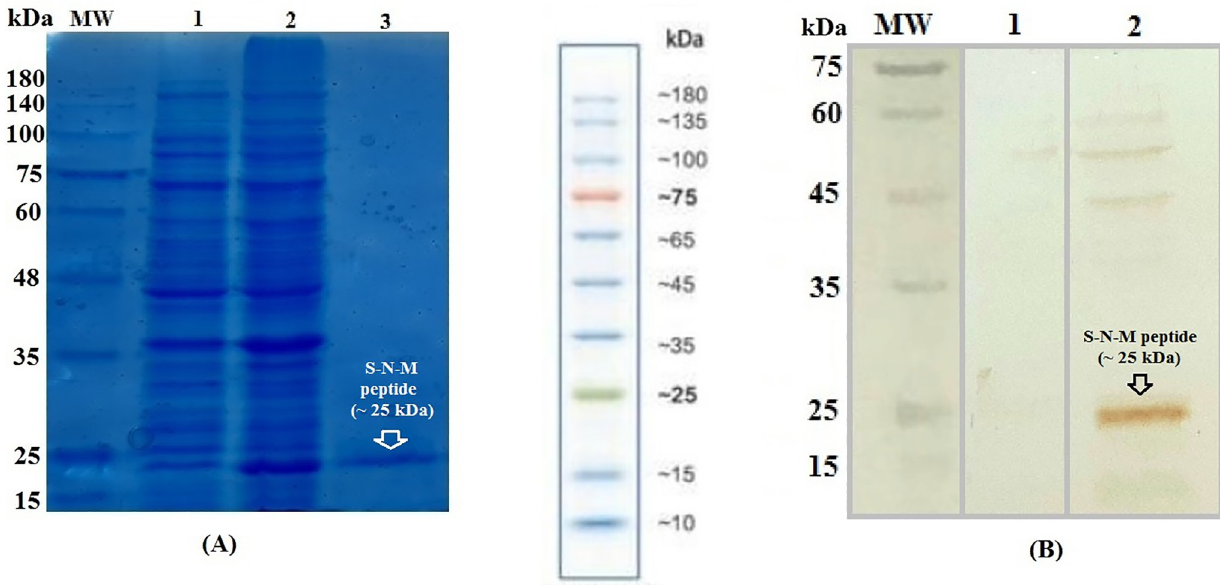
Fig 6. A) Generation of the recombinant S-N-M peptide in Rosetta strain: Lane 1: before induction; Lane 2: 16 hours after IPTG induction; Lane 3: Purified peptide; B) Confirmation of the expressed S-N-M multiepitope peptide using western blotting: Lane 1: before induction; Lane 2: 16 hours after induction; MW: Molecular weight marker (prestained protein ladder, 10–180 kDa,